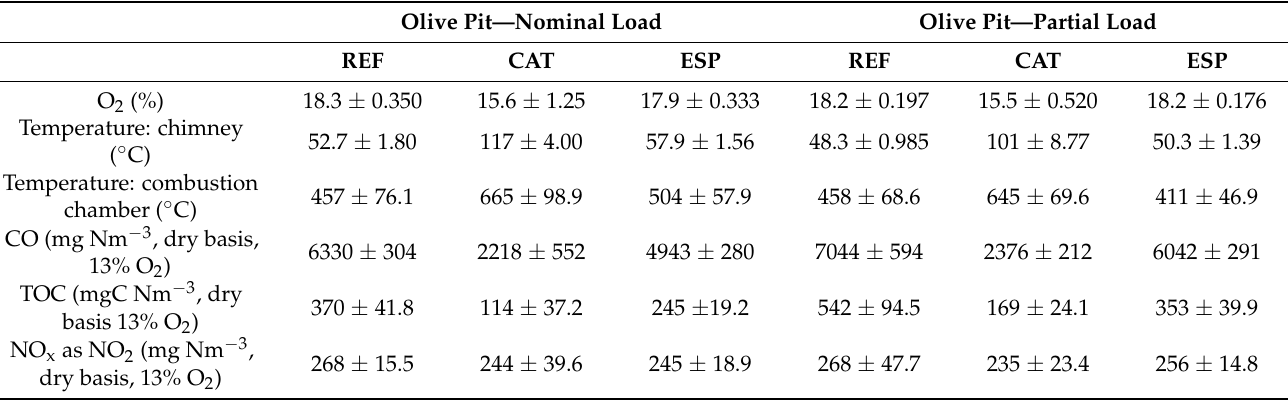
Table 4. Operating parameters of olive pit combustion and CO, TOC, and NO x emission concentration at 13% of oxygen. Olive Pit—Nominal Load Olive Pit—Partial